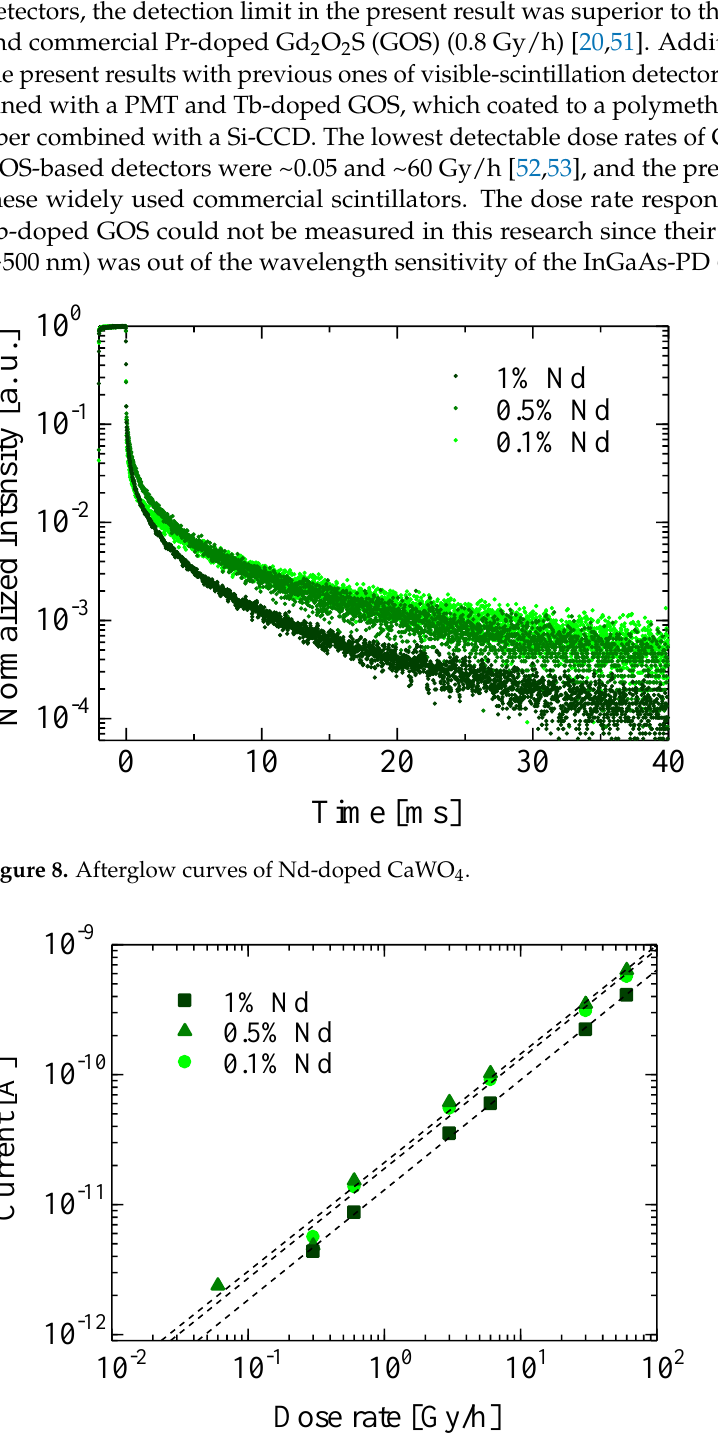
Figure 9. Relationships between the X-ray exposure dose rate and the intensity in the NIR ranges of the crystals.